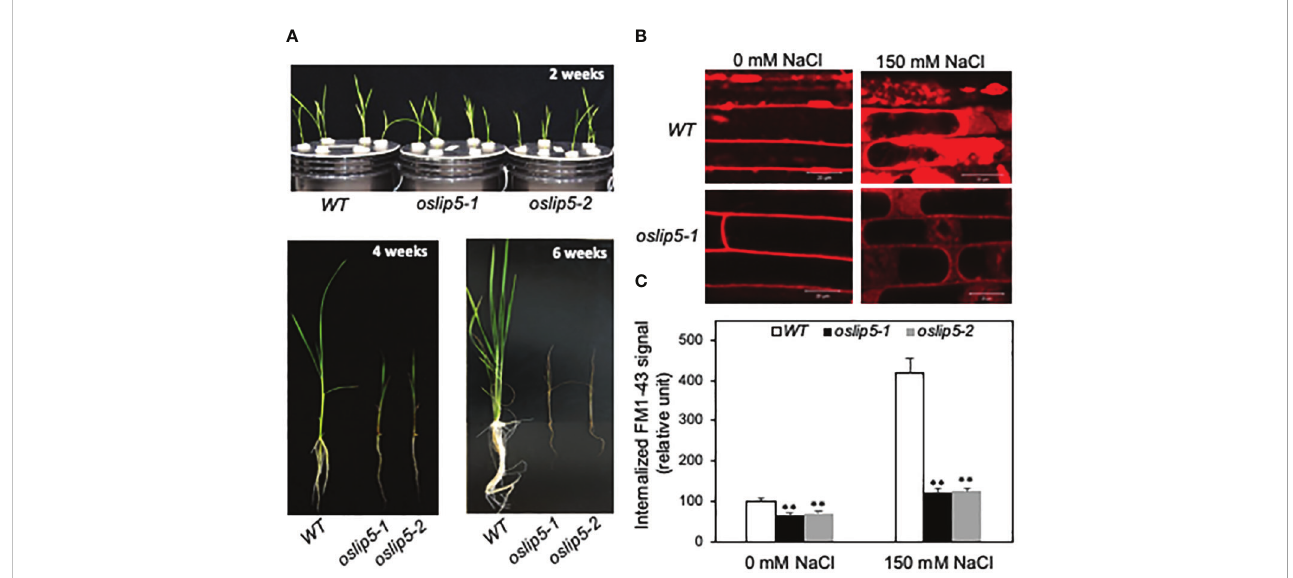
FIGURE 4 Phenotypes of rice WT, oslip5 mutants in growth and endocytosis. Comparison of growth of 2-, 4- and 6-week-old rice WT, os lip5-1 and os lip5-2 mutants grown hydroponically under normal growth conditions (A) . Five-day-old rice seedlings were treated with 0 or 150 mM NaCl for 20 h. Basal and salt-induced endocytosis was analyzed using FM1-43 as indicated by the representative confocal images of rice root epidermal cells after FM1-43 staining (B) . Bars =20 m m. The fl uorescent signal intensity of internalized FM1-43 was determined from 20 Z stack images of root epidermal cells (C) . Means and SE were calculated from images of 10 independent roots (20 images per root). Double asterisks indicate statistically signi fi cant difference at P<0.01 in the levels of internalized FM1-43 signal between Col-0 WT and atlip5 mutant lines with the same salt